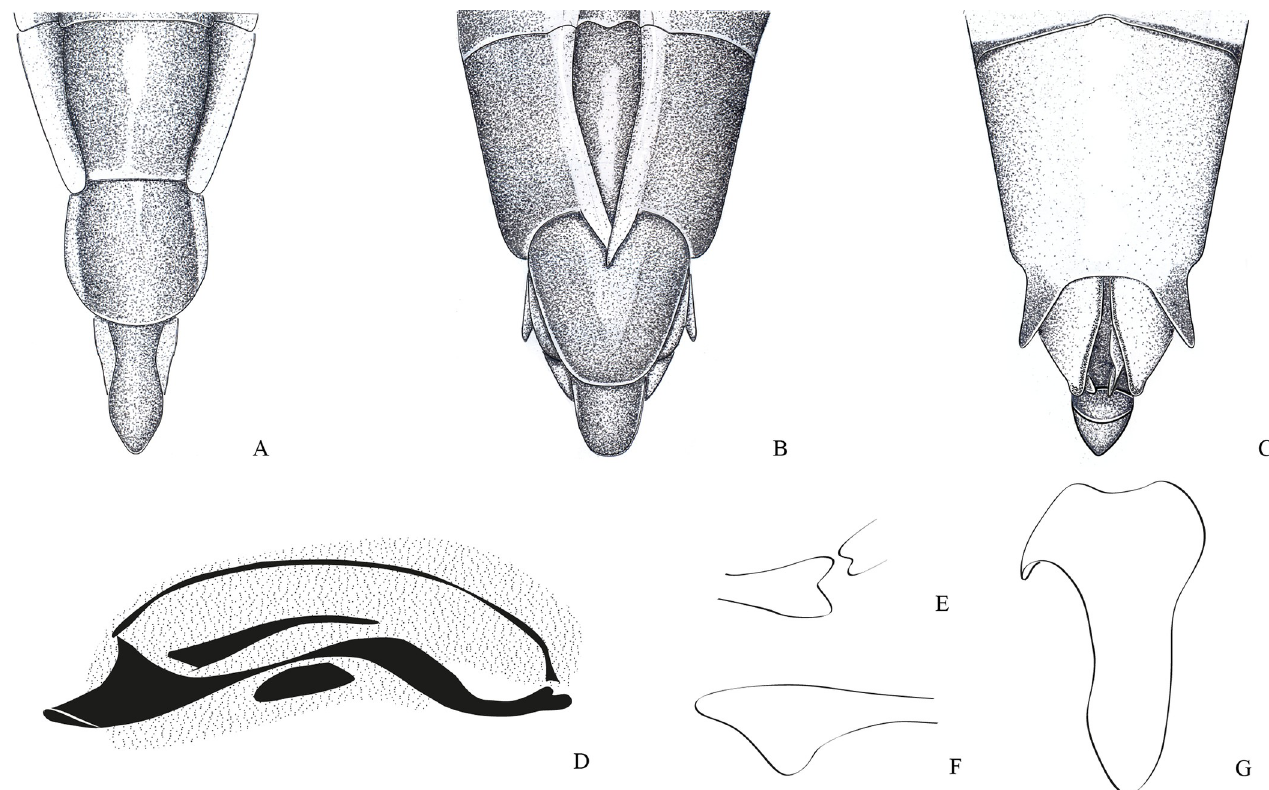
Fig 6. Brailovskybates thomasi . new comb. (A) Male, terminalia, ventral view; (B) female, terminalia, ventral view; (C) female, terminalia, ventral view; (D) phallus, lateral view; (E) junction between dorsal and ventral sclerite; (F) base ventral sclerite; (G) proctiger, dorsal view.